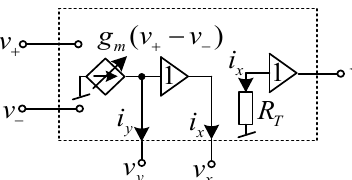
Figure 1. Symbol notation of LT1228.